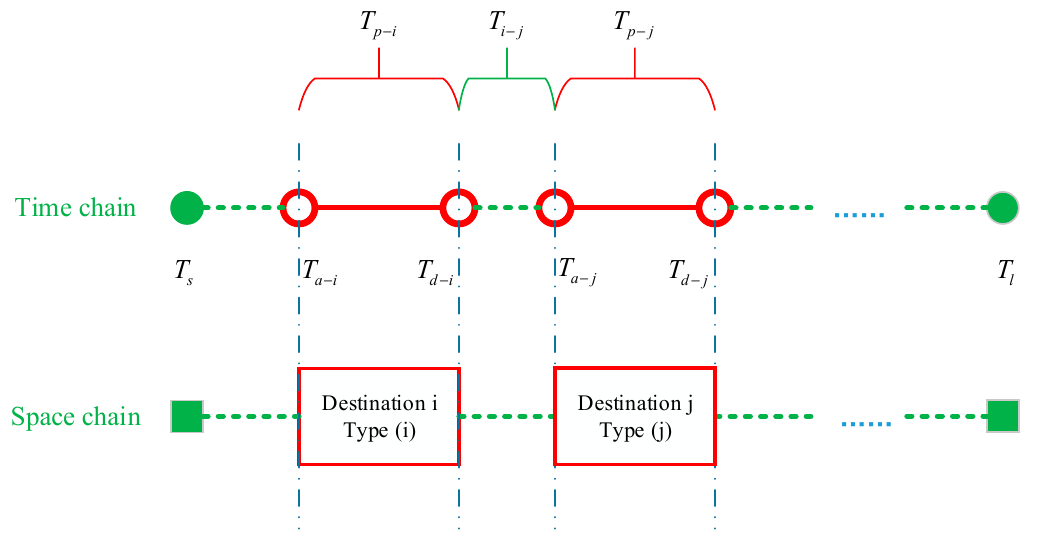
Figure 3. Travel chain diagram.